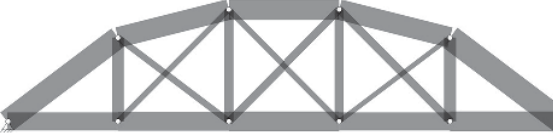
Fig. 5. Comparative scheme of optimal truss elements cross- sections (according to Table 1)